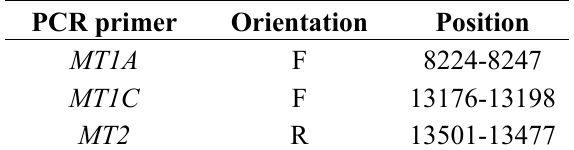
Table 1. PCR primers for detection of the “common deletion” in